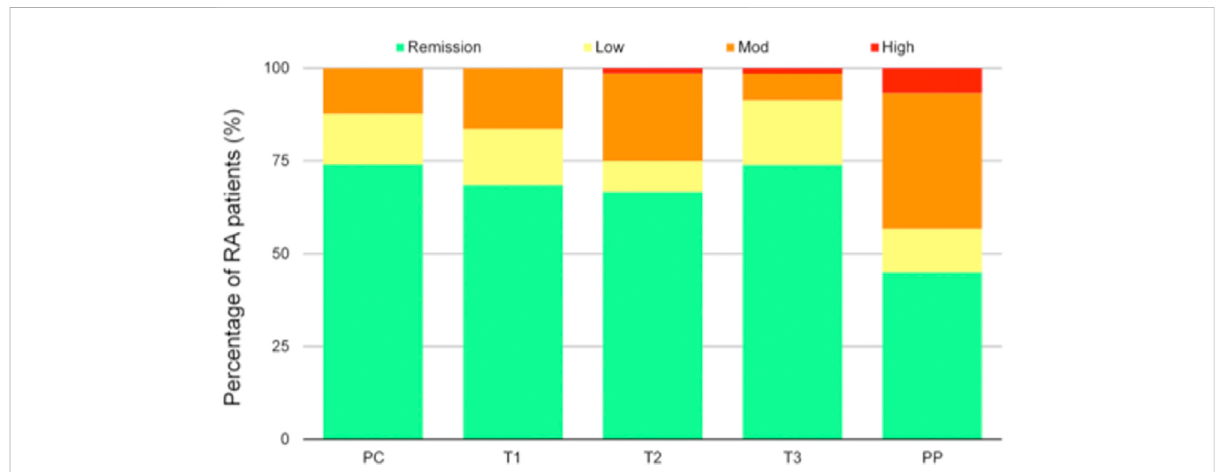
FIGURE 1 DiseaseactivityaccordingtoDiseaseActivityScorein28joints(DAS28)duringpregnancyandpostpartum,classi fi edasremission(DAS28 < 2.6), low disease activity (DAS28 2.6 – 3.2), moderate disease activity (DAS28 3.2 – 5.1), and high disease activity (DAS28 > 5.1). RA, rheumatoid arthritis; PC, preconception visit; T1 fi rst trimester, T2 second trimester, T3 third trimester, PP